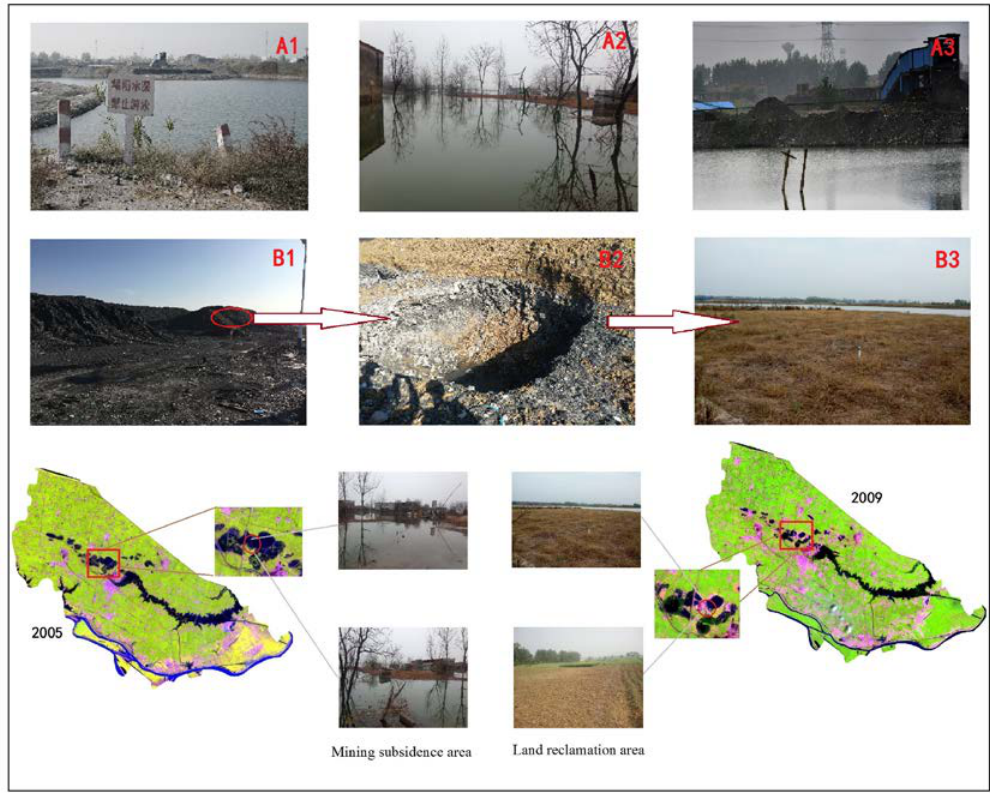
Figure 8. Schematic diagram of subsidence and reclamation in mining